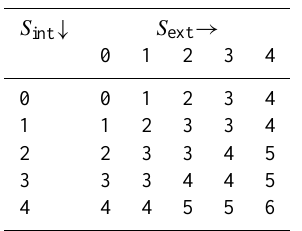
Table 4. Lake outburst susceptibility rating S : combination of S ext and S int